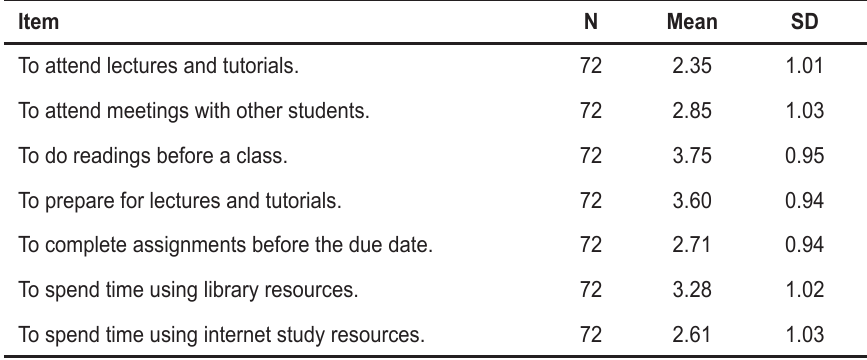
Table 4: Perceived work-study conflict